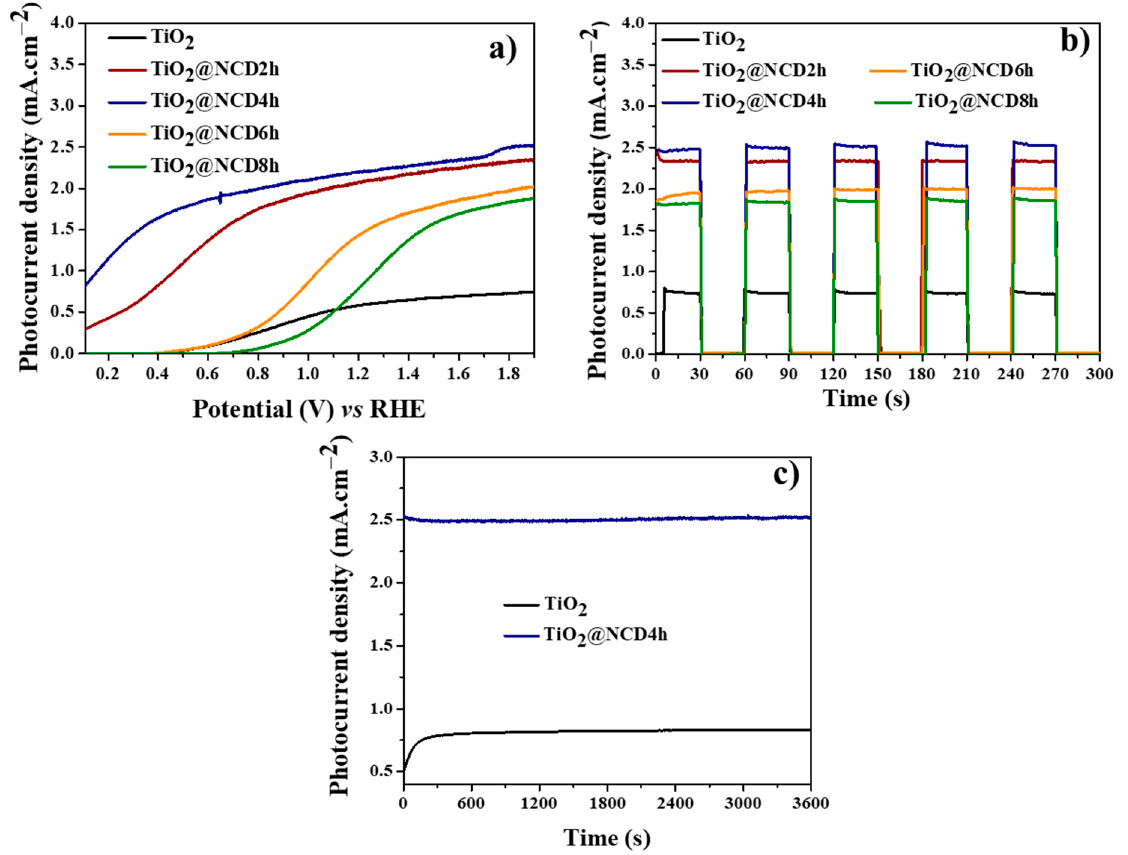
Figure 7. ( a ) Photocurrent density vs. applied potential curves; ( b ) Transient photocurrent density curves at 1.89 V vs. RHE of the as-prepared photoelectrodes; ( c ) Stability test of pristine TiO 2 and TiO 2 @NCD4h at 1.89 V vs. RHE.